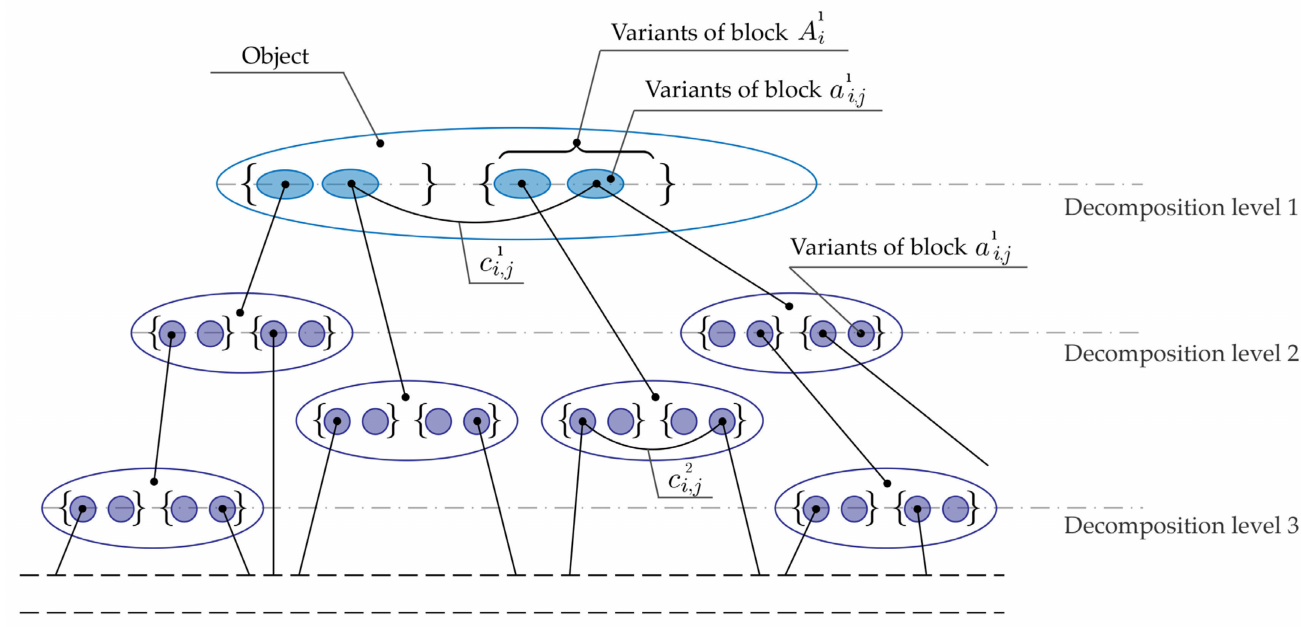
Figure 1. Variant tree for the block connection pattern of the object, where a k i —number of groups, j —number of blocks in a group, k —decomposition level number, c k connection variant, i , j , k —decomposition level